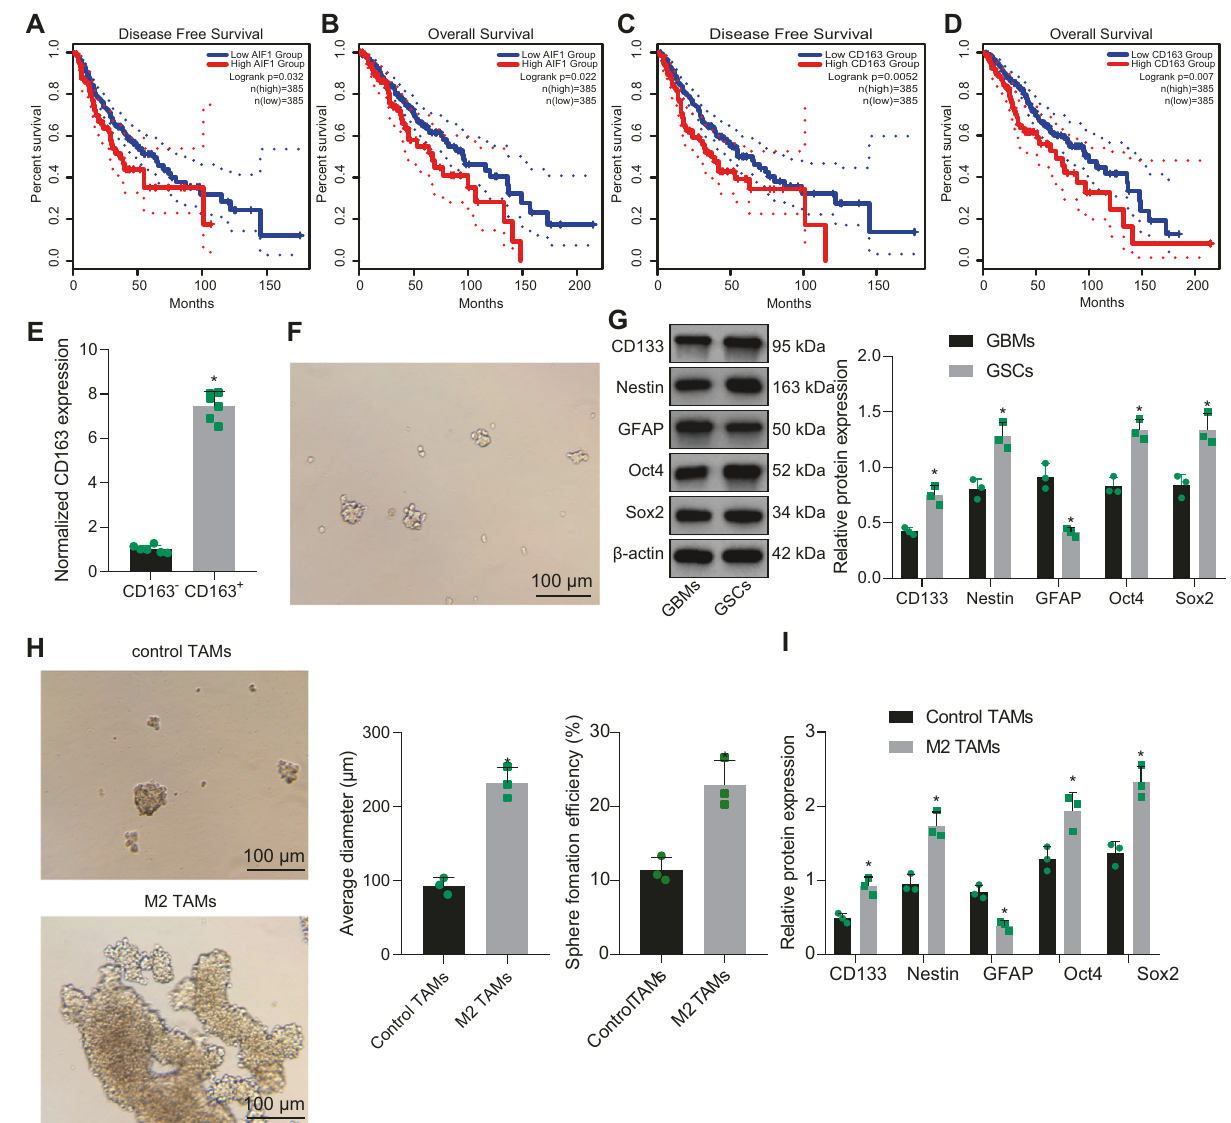
Fig. 1 M2-TAMs maintain the properties of GSCs. Kaplan – Meier survival analysis of progression-free survival ( A ) and overall survival ( B ) of GBM patients with low or high Iba1 expression using GEPIA (http://gepia2.cancer-pku.cn/#index) in TCGA database (https://portal.gdc.cancer. gov/). Kaplan – Meier survival analysis of progression-free survival ( C ) and overall survival ( D ) of GBM patients with high or low CD163 expression using GEPIA in TCGA database. E RT-qPCR was utilized to analyze the expression of CD163 in the CD11b + /CD163 + and CD11b + / CD163 − TAMs from 6 GBM patients sorted by FACS. F The morphology of GSCs. G Western blot analysis of stem cell-related proteins CD133, Nestin, Oct4, Sox2, and GFAP. H Representative images showing neurosphere formation of GSCs along with the statistics of GSC neurosphere formation rate and diameter. I Expression of stem cell-related protein CD133, Nestin, Oct4, Sox2 and GFAP in GSCs measured by Western blot analysis. * p < 0.05 vs. CD163, GBMs or control TAMs. Measurement data were depicted as mean ± standard deviation, and comparison of data between two groups was conducted by unpaired t test. Cell experiments were repeated three times independently. transcription quantitative polymerase chain reaction (RT-qPCR) RESULTS that compared with control TAMs, the expression of CD163 was M2-TAMs promote the viability of GSCs increased in M2-TAMs sorted by FACS (Fig. 1E). Accordingly, TAMs To further elucidate the molecular mechanism of M2-TAMs in could be recruited by GSCs and maintained as M2-TAMs to tumor promotion, GEPIA was utilized to obtain the potential promote GBM tumor growth. relationship between the survival rate of GBM patients and the Next, GSCs were isolated, the stemness of which was fi rst expression of pan-TAM marker Iba1 (also named AIF1 in NCBI) and assessed. Increasing evidence suggests that Oct4 and Sox2 are M2-TAM marker CD163 in TCGA database. Kaplan – Meier analysis marker proteins of stem cells and tumor stem cells, which are results showed that GBM patients with lower expression of Iba1 or essential for the maintenance of tumor stem cell stemness CD163 had a relatively better prognosis (Fig. 1A – D). Next, the [5, 18, 19]. In addition, neural stem cell marker proteins CD133 tumor-supporting M2-TAMs (CD11b + /CD163 + ) and control TAMs and Nestin have also been found to be marker proteins of glioma (CD11b + /CD163 − ) were sorted by fl uorescence-activated cell stem cells, and their high expression is crucial for the self-renewal sorting (FACS) using the well-known TAM labeling CD11b and and proliferation of GSCs [18, 20]. GFAP is an intermediate the classic M2-TAM labeling CD163. It was con fi rmed by reverse Cell Death Discovery (2022)